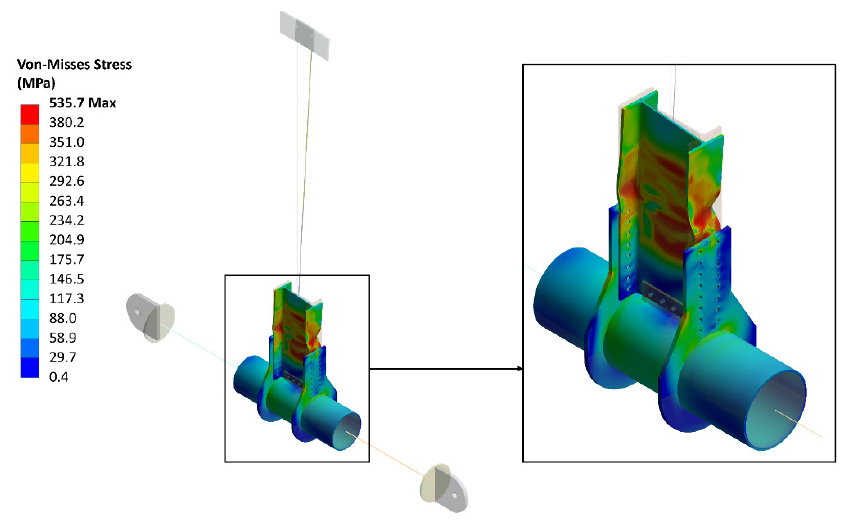
Figure 17. Local buckling effect predicted by the numerical model after the second-stage simplifica- tions.